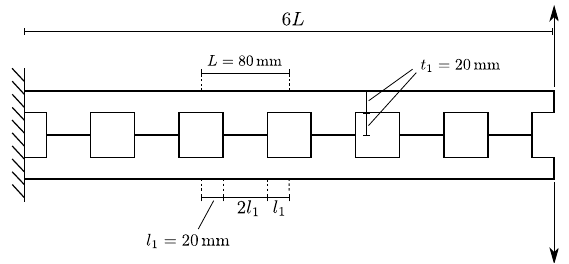
Figure 14. Cantilever perforated beam: geometry and dimensions.